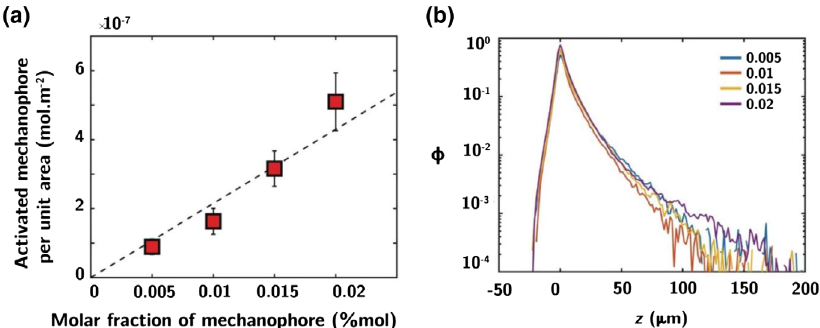
FIG. 8. Linear dependence of fluorescence intensity with mechanophore concentration. (a) Linear dependence of activated mechanophore per unit area as a function of the molar fraction of mechanophore. (b) Absolute damage profiles ϕ ð z Þ for various molar fractions of mechanophore.